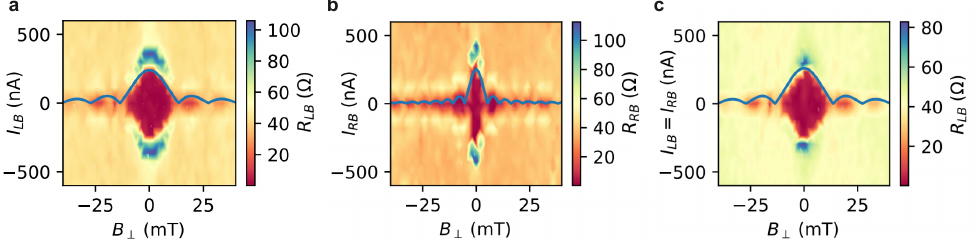
Figure 7. Differential resistances under perpendicular magnetic field sweep: ( a ) A map of R LB as a function of B ⊥ and I LB for I RB = 0. ( b ) The corresponding map of R RB as a function of B ⊥ and I RB for I LB = 0. In ( c ), the sweep current is chosen to be I LB = I RB , which corresponds to a sweep along the diagonal in the current plane. In all cases, a standard Fraunhofer pattern is fitted indicated as blue